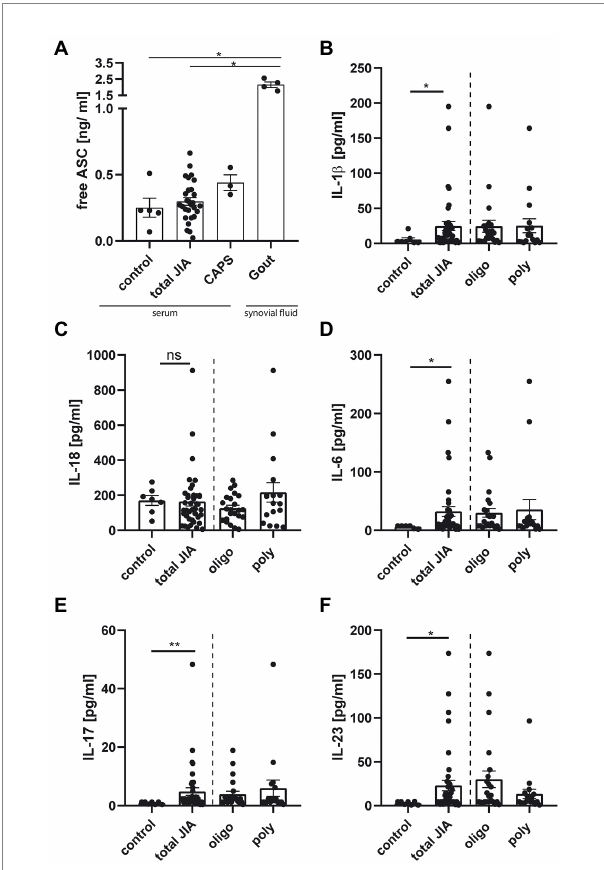
FIGURE 3 Cytokine levels, but not the amount of free ASC, are elevated in serum from JIA patients compared to control. (A) Quantification of free ASC in serum from five pediatric controls, three CAPS-, 31 JIA- patient samples and in the synovial fluid of four gout patients. (B–F) Quantification of cytokine levels from seven pediatric controls, and 41 JIA- samples measured in duplicates, represented as the mean from them. (A) Kruskal–Wallis test followed by Dunn’s multiple comparison test against control and (B-F) Mann–Whitney U -test were performed. A p -value * p < 0.05, ** p < 0.01, or *** p < 0.001 was considered significant, shown mean ±